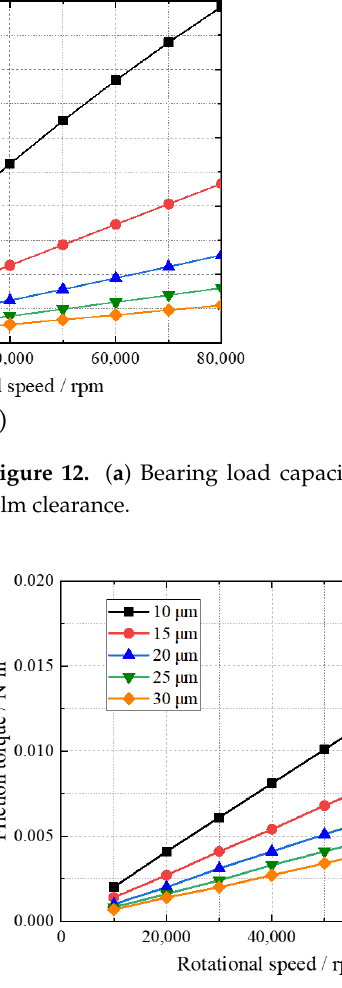
Figure 13. Friction torque of hydrogen gas bearings with gas film clearance.